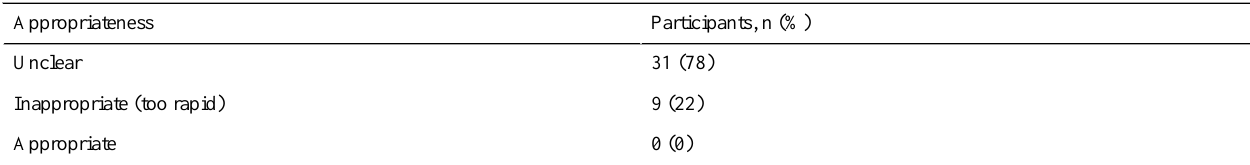
Table 4. Appropriateness of tapering schedule